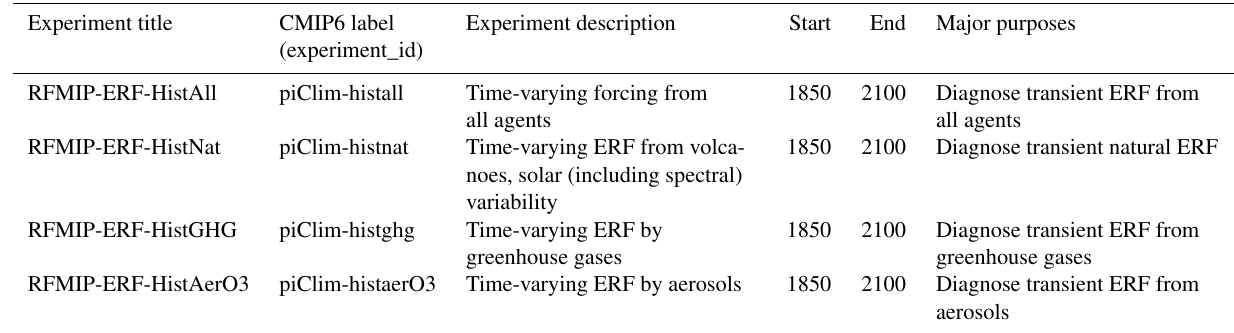
Table 2. Experiments for diagnosing time-evolving effective radiative forcing. Three-member ensembles of atmosphere-only integrations interactive vegetation and using sea-surface temperatures and sea ice concentrations fixed at model-specific preindustrial control climatology. Forcing post-2015 uses a scenario consistent with DCPP and DAMIP